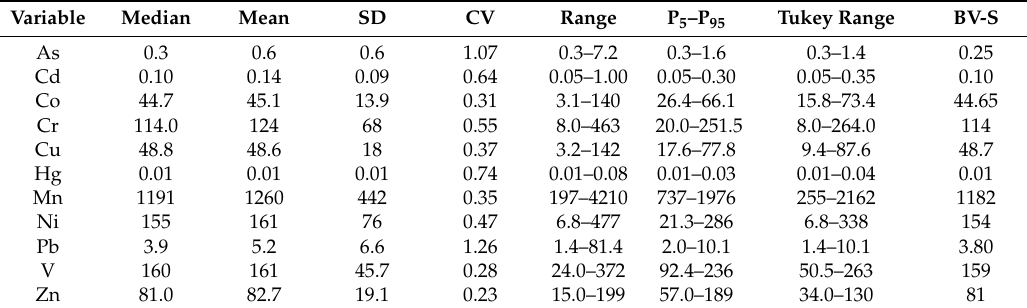
Table 2. Statistical As, Cd, Co, Cr, Cu, Hg, Mn, Ni, Pb, V and Zn variables analysed, interval ranges,